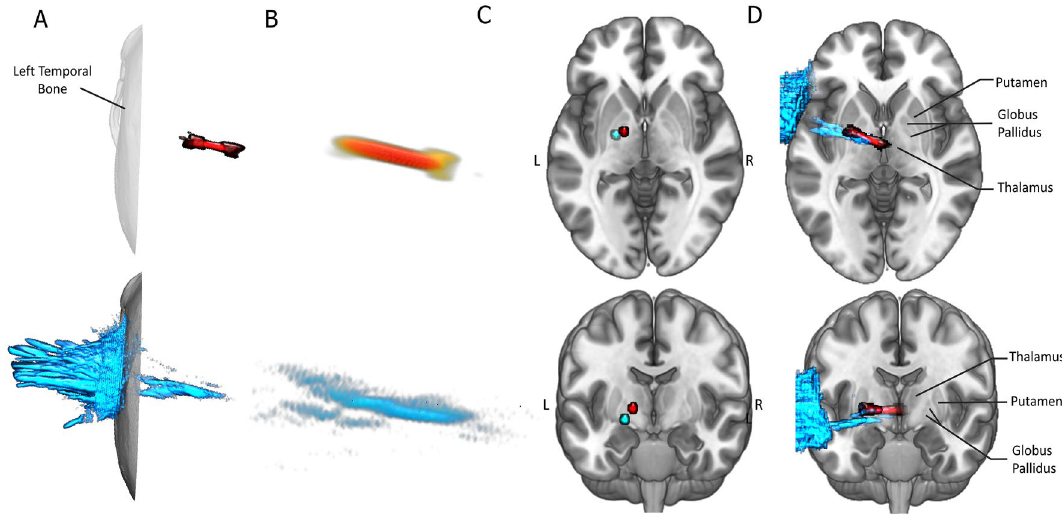
Figure 2. Numerical Modeling through Bone and Water. Here, one 5 ms pulse (corresponding to 1 pulse of Mode 2) of our ultrasound beam is simulated twice, in water (red), and through the temporal bone of a human computed tomography (CT) image (cyan). The same trajectory, which targets the left GP, was used in both simulations. The maximal pressure for each voxel over the course of the simulation is visualized. Only Voxels exceeding 50% (-3 dB) of the maximum in-brain pressure are presented. ( A ) Depiction of the effect of bone on beam shape and position. Note that bone (bottom, cyan) appears to flatten, deform, and laterally retract the ultrasound beam compared to the water condition (top, red). However, the general expression of an elongated beam and its general location is retained. Further note that most energy ( A , bottom) is deposited into and reflected off bone when it is present. ( B ) Higher-resolution depiction of ultrasound beam in water (B, top) and through bone (B, bottom). ( C ) Location of maximum pressures following propagation through water (red) and through bone (cyan). Points were mapped into MNI space for visualization. Note that both reside inside the left pallidal target. While the effect of bone moves the peak pressure somewhat ventral and lateral, the total translation is 0.93 cm. ( D ) Depiction of whole ultrasound beam through water (cyan) and bone (red). Simulations were mapped into MNI space for visualization. Note that energy deposition into portions of the left lentiform nuclei and left thalamus exceeded the threshold of − 50% maximum